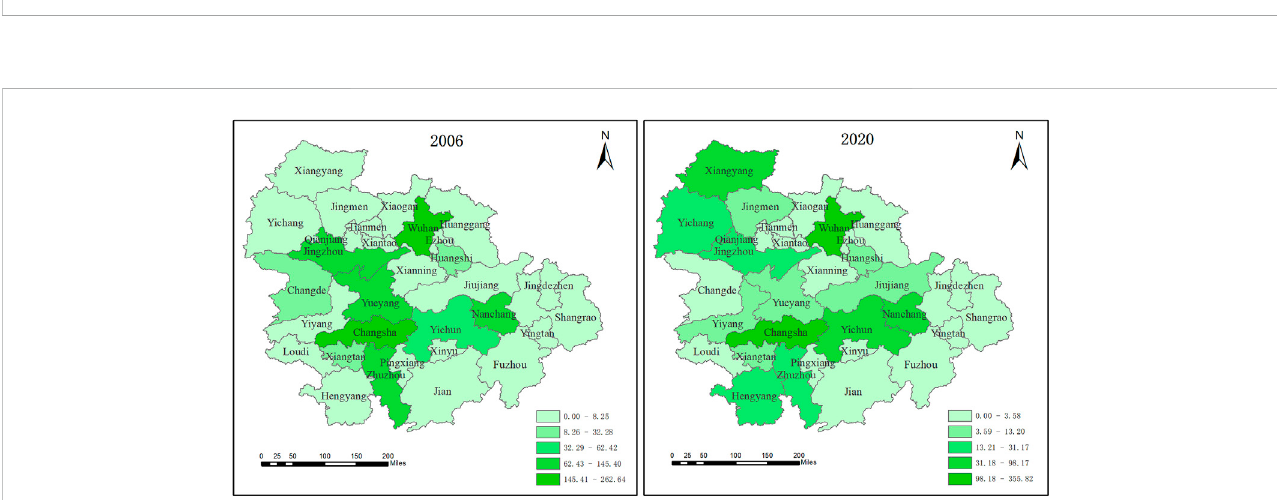
FIGURE 7 The betweenness centrality of 2006 and 2020 in the middle reaches of Yangtze River urban agglomeration.